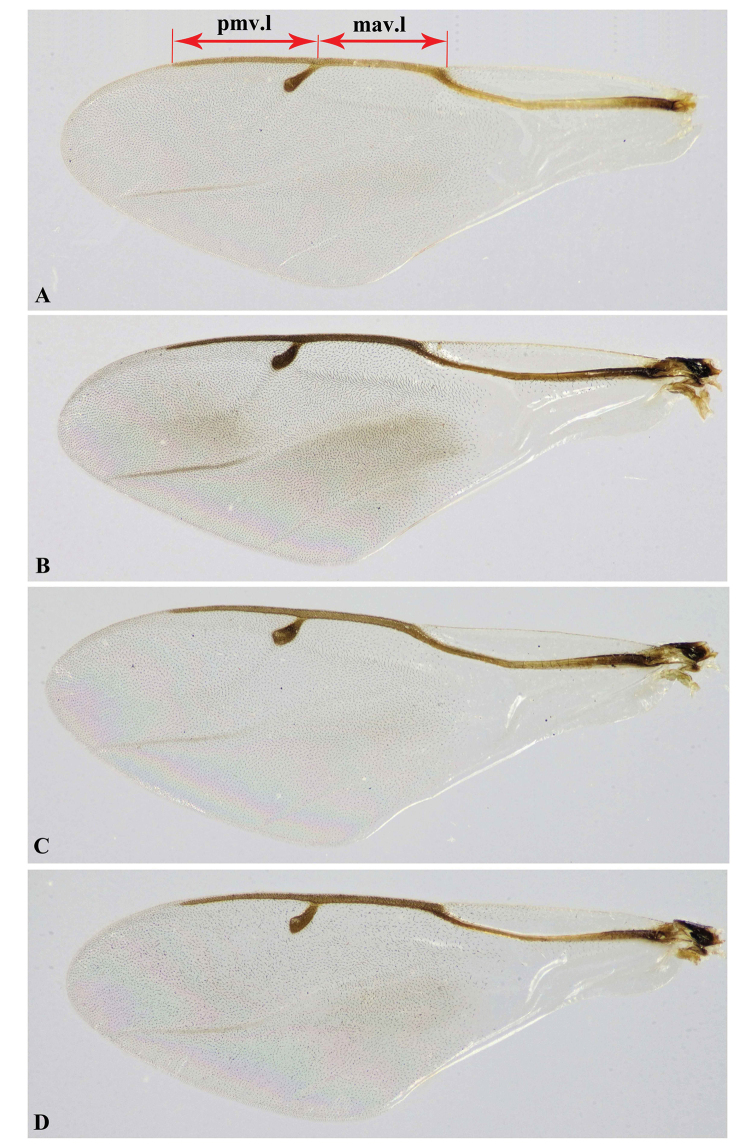
Forewing, Holotype AOodera
arabica sp. nov. BOodera
omanensis sp. nov. COodera
rapuzzii sp. nov. DOodera
similis sp. nov.